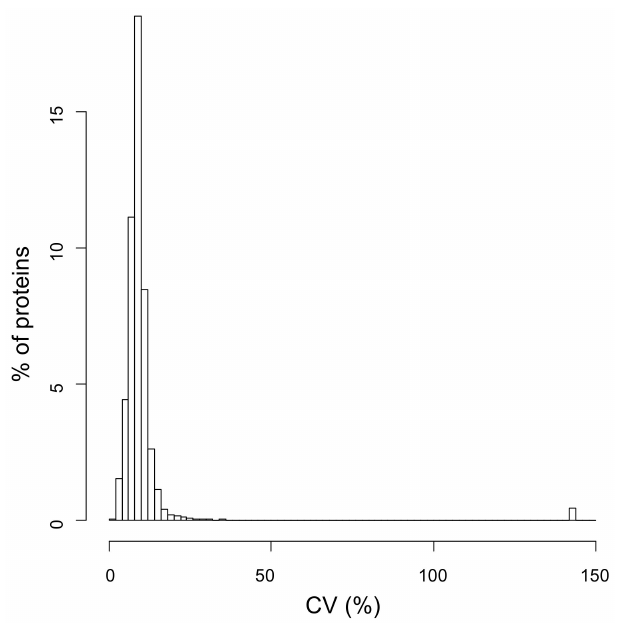
Figure 3. Coefficient of variation of the parameter estimate. Distribution of the CV of the parameter k estimate of the 1661 proteins in our dataset identified by fitting the H/L ratio across different time